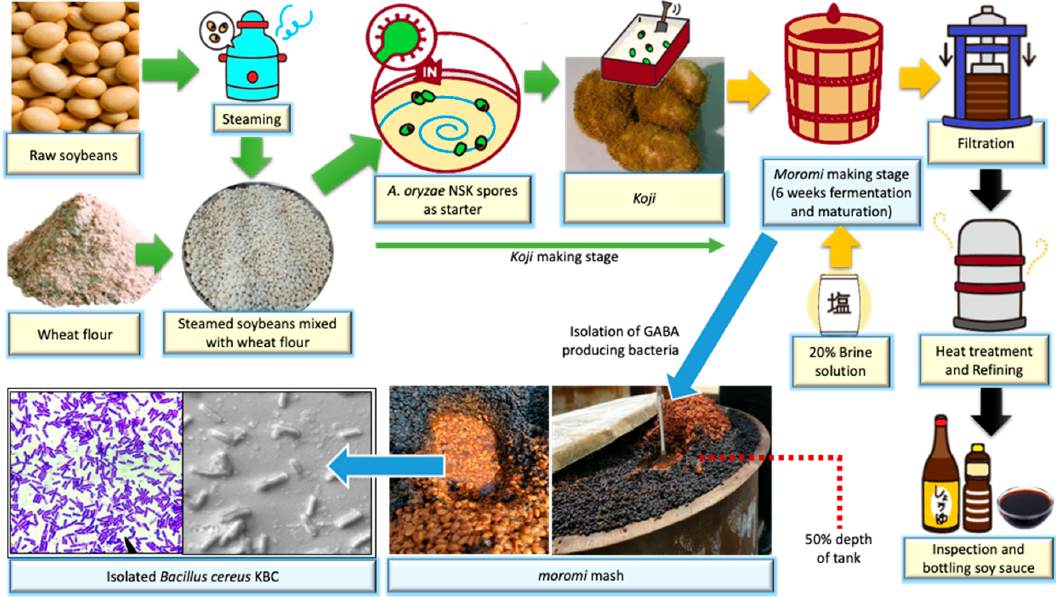
Figure 1. Soy sauce production blueprint and isolation point for Bacillus cereus strain KBC.